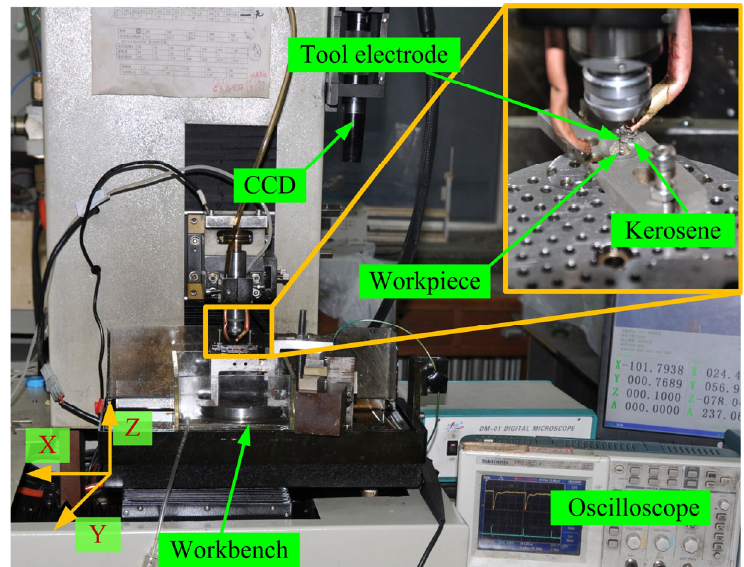
Figure 3. Photograph of experimental set ‐ up.